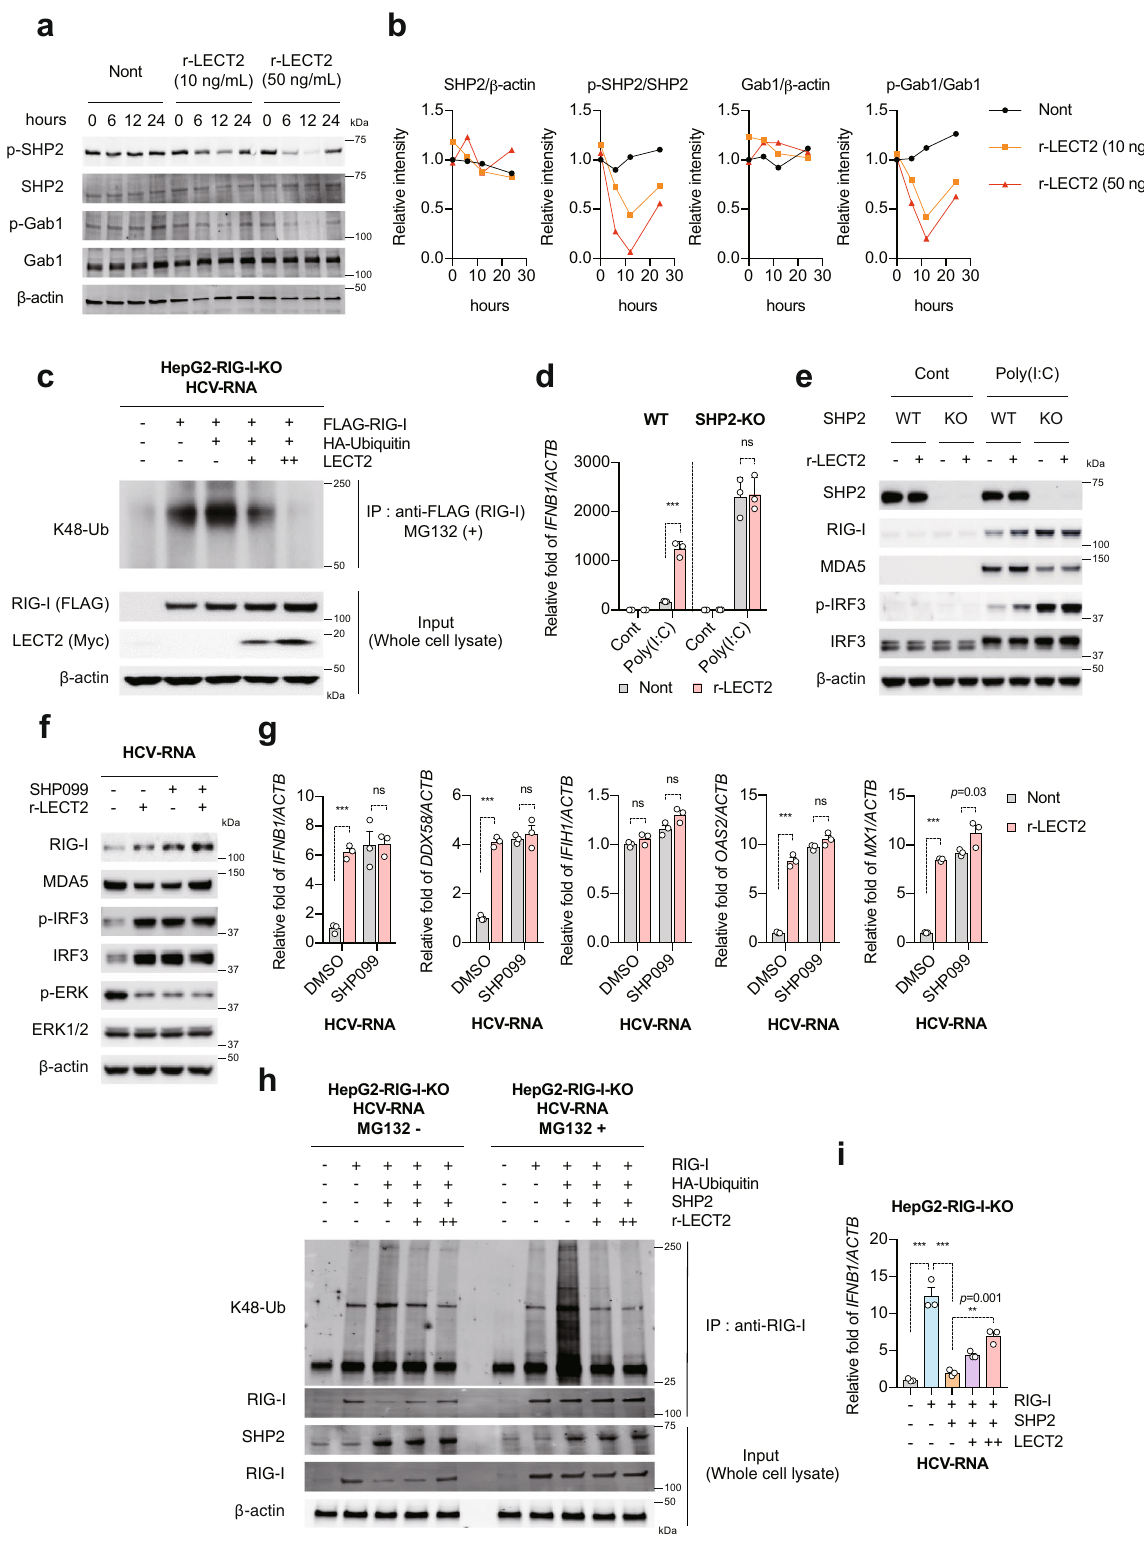
(Fig. 7d). In the presence of MET and PTP4A1, r-LECT2 strongly inhibited HCV replication (Fig. 7e). Next, we performed immu- no fl uorescence staining to con fi rm PTP4A1 recruitment to MET visually. In the absence of r-LECT2, MET and PTP4A1 co- localization were partially consistent; however, in the presence of